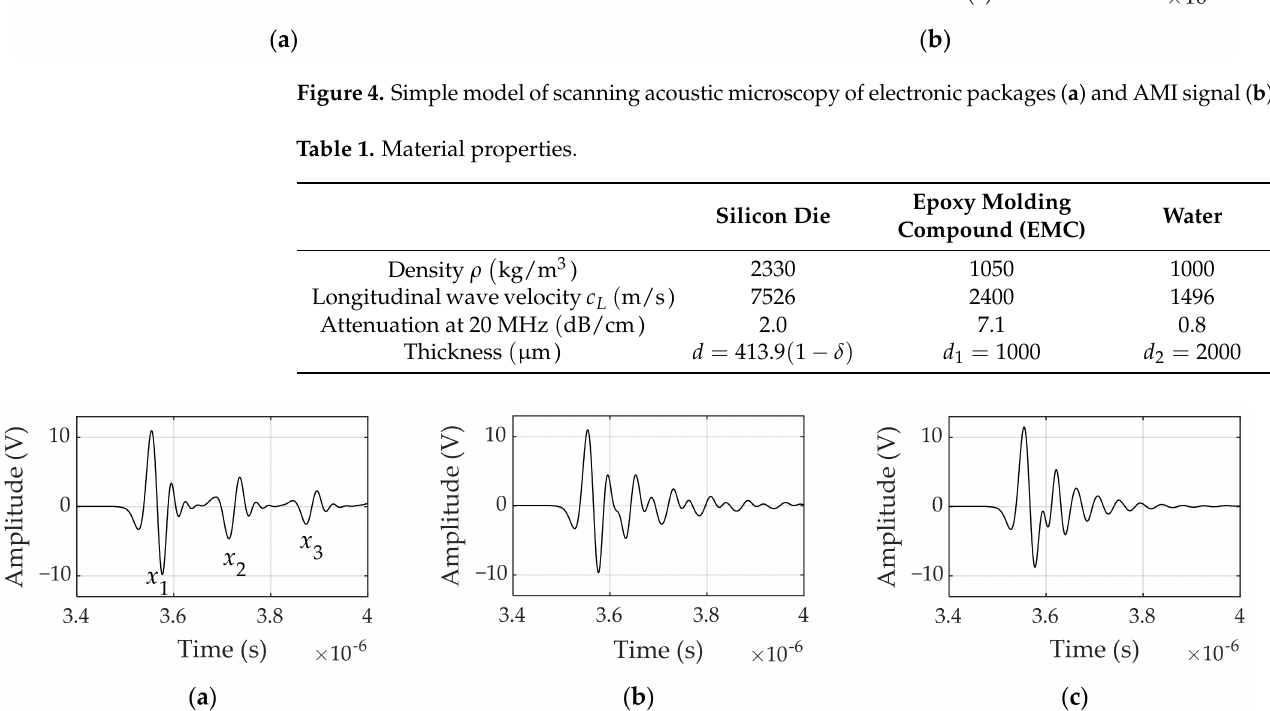
Figure 5. AMI signals with different degrees of overlap: ( a ) δ = − 45%; ( b ) δ = 30%; ( c ) δ =